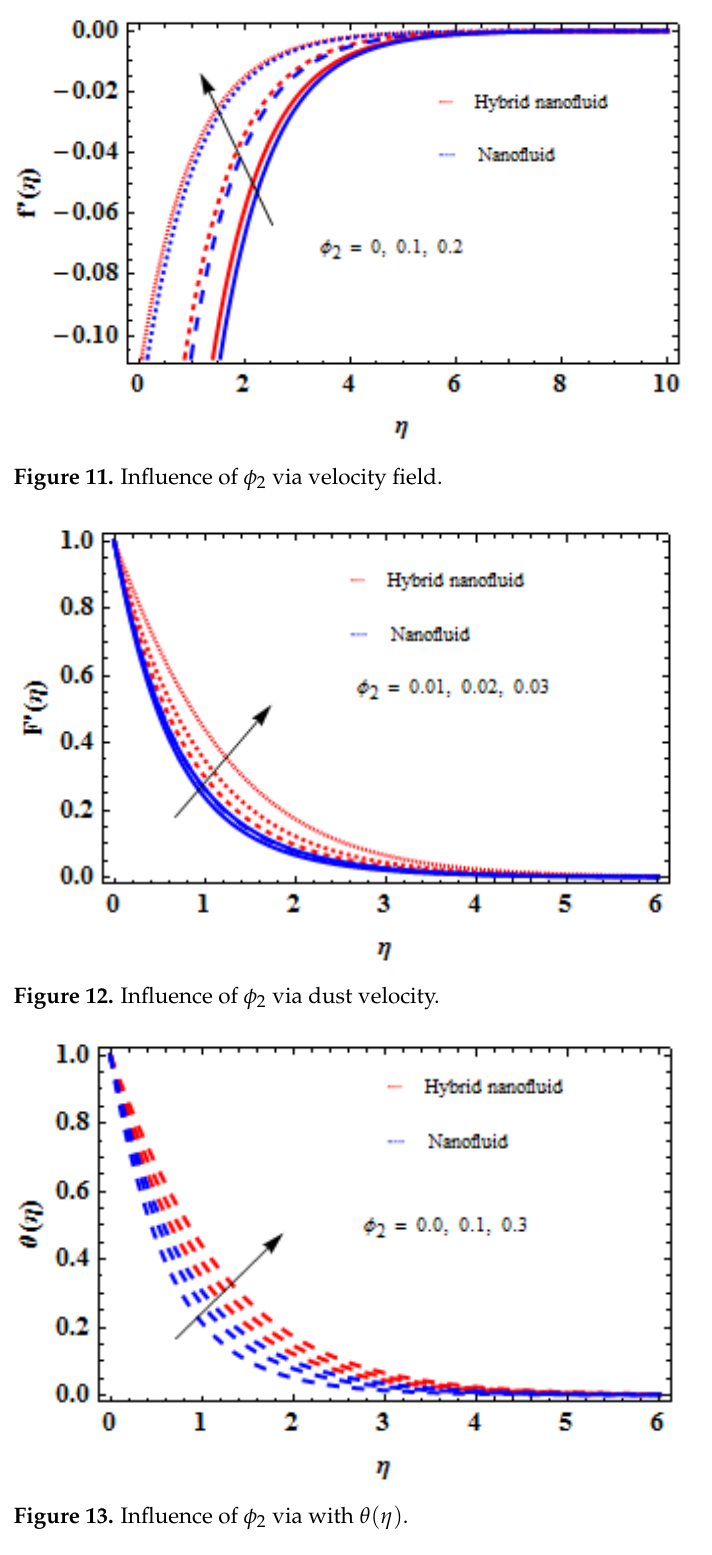
Figure 10. Influence of 𝐾 𝑝 via dust temperature.